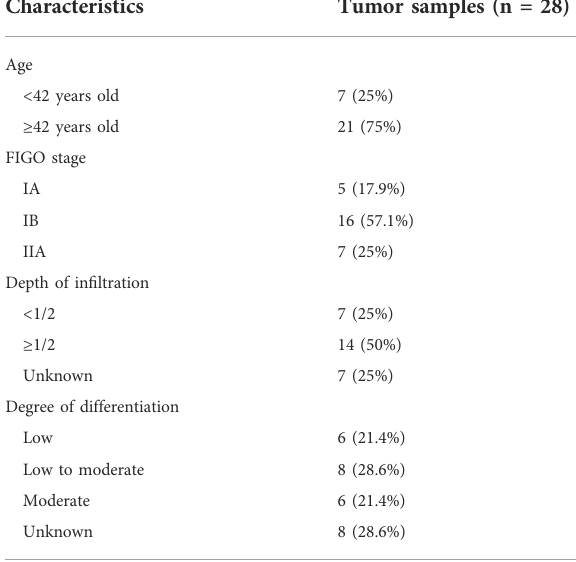
TABLE 3 The information of tumor samples for